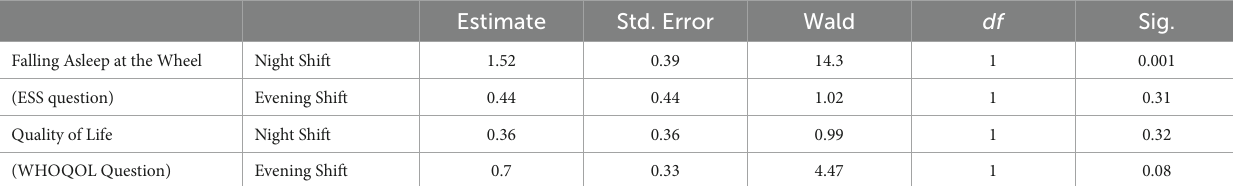
TABLE 5 Results from ordinal regression models testing the impact of shift type on likelihood of falling asleep at the wheel and quality of life